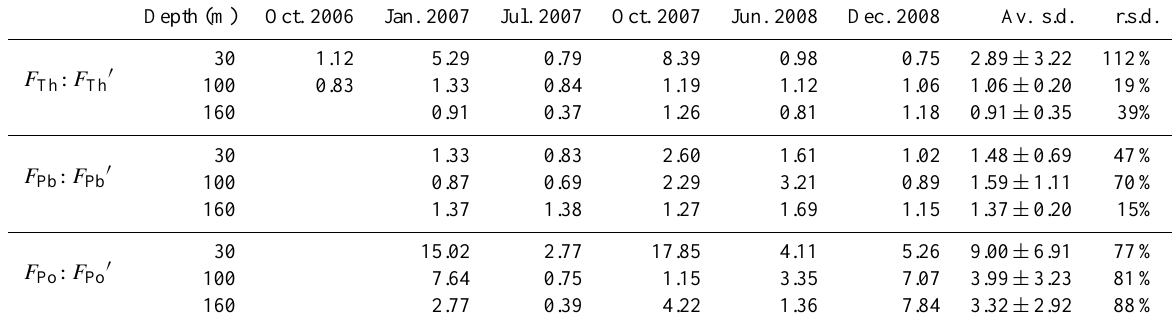
Table 3. Trapping efficiencies estimated by the ratios of measured and modeled fluxes of 234 Th, 210 Pb, and 210 Po from the three depths for all cruises. Average value, standard deviation, and relative standard deviation for each depth are